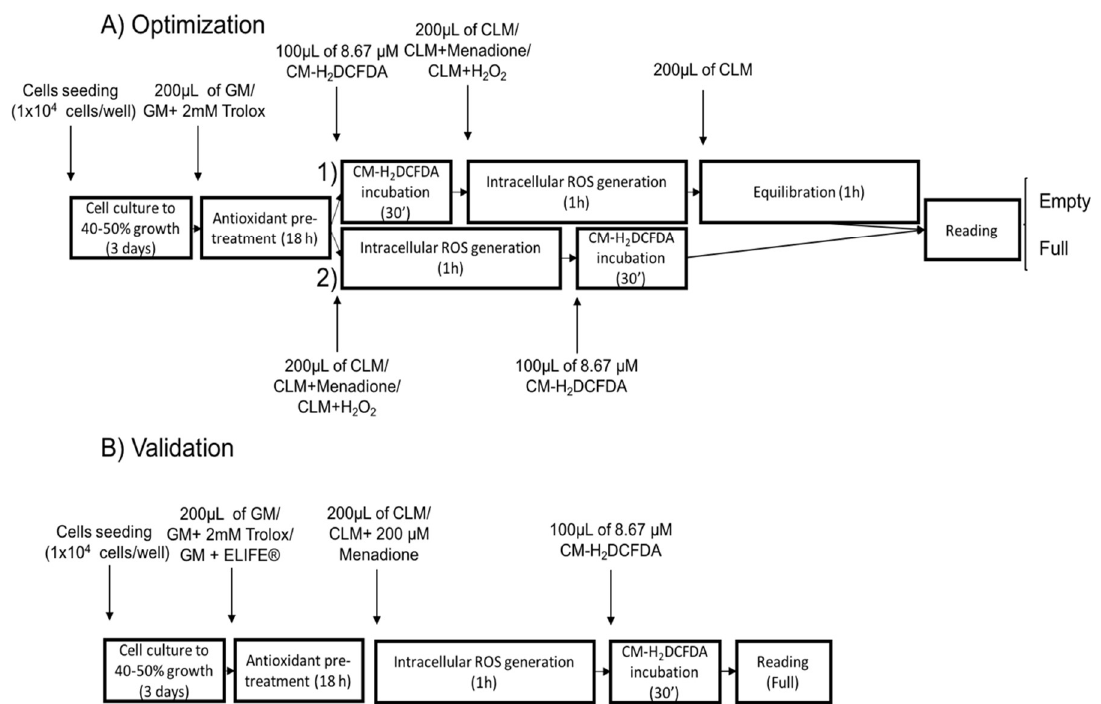
Figure 6. Graphical overview of the different steps included in ( A ) the optimization and ( B ) validation of the in vitro oxidative stress measurement. (1) and (2) are different protocols tested during the optimization process in order to obtain the best signal-to-noise ratio. GM refers to growth medium, CLM refers to colorless growth medium and ROS to reactive oxygen species. Fluorescence (Ex/Em: 495/520 nm) was detected under two different conditions: before (full) and after (empty) discarding the buffer containing the CM-H2DCFDA probe and washing the wells twice with PBS.